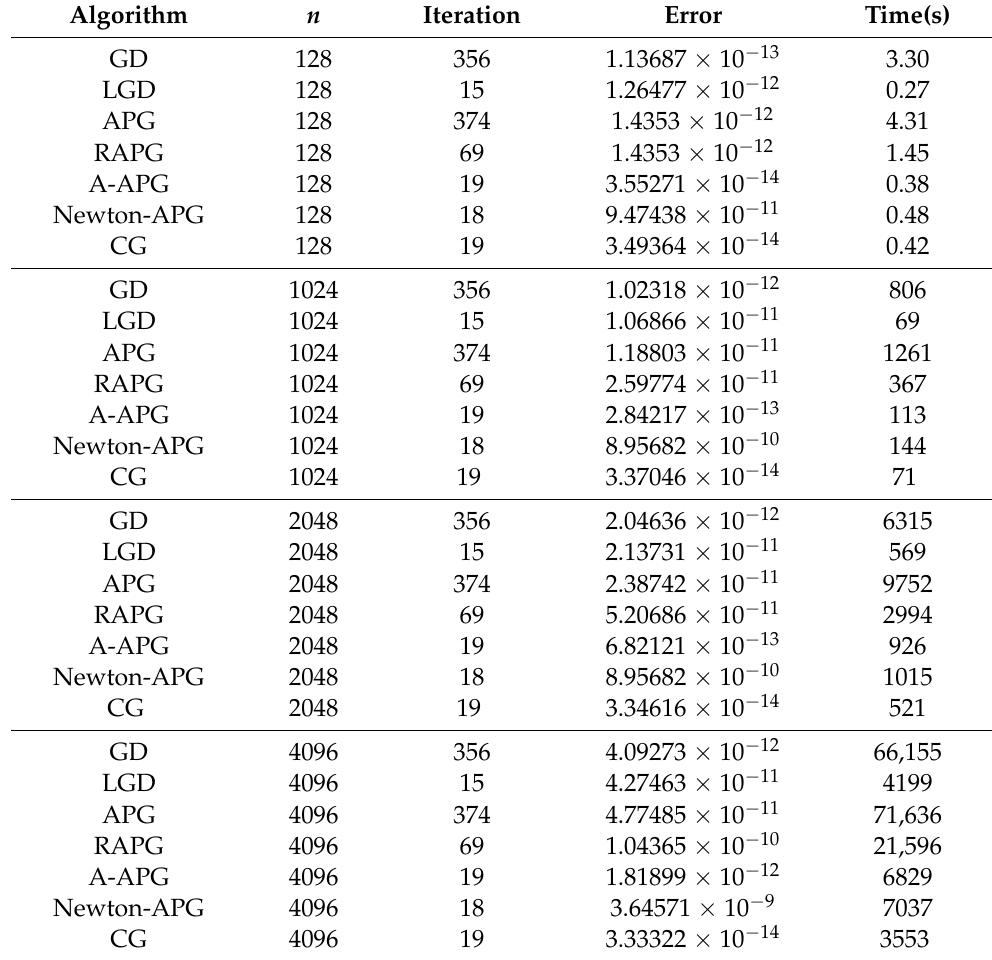
Table 1. Numerical results for Example